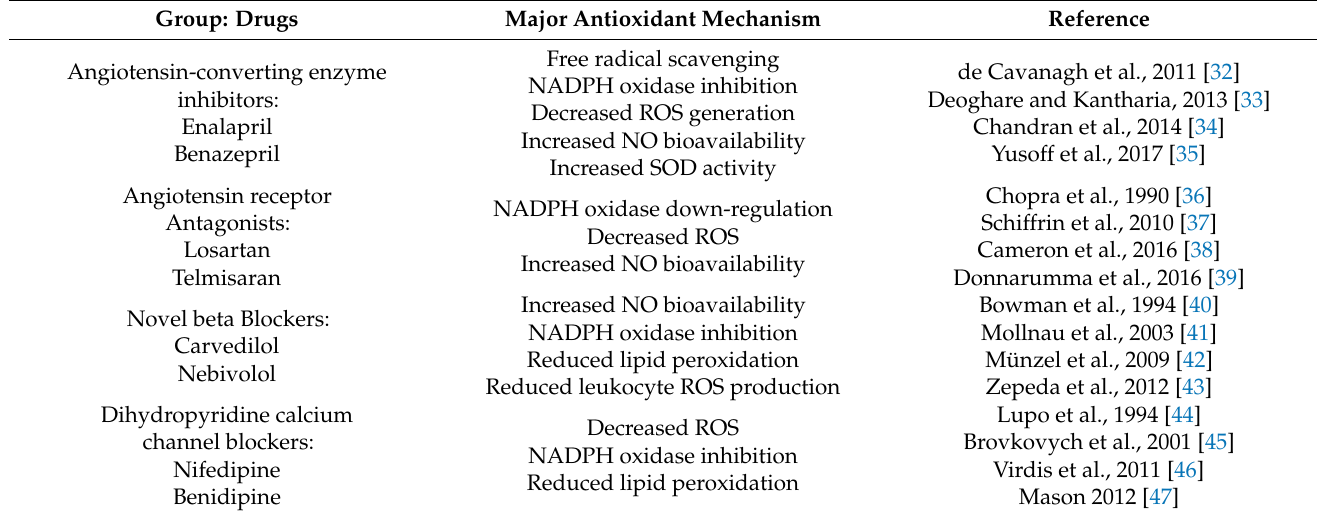
Table 1. Antioxidant mechanisms are involved in the pharmacological effects of currently used antihypertensive drugs. Group: Drugs Major Antioxidant Mechanism